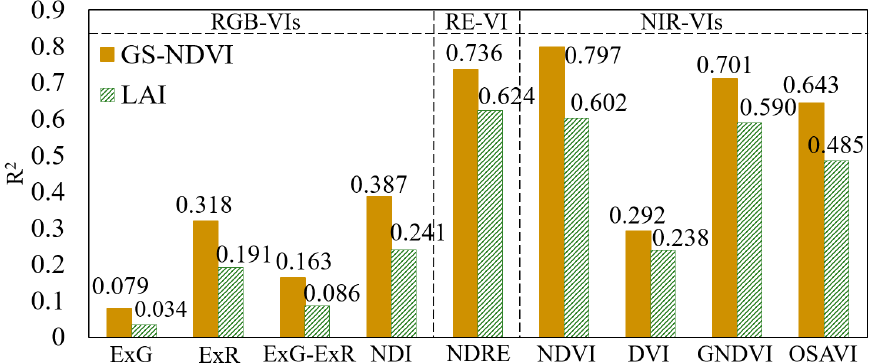
Figure 5. Correlation (R 2 ) between ground-measured parameters (GS-NDVI and LAI) and different ASD-VIs.